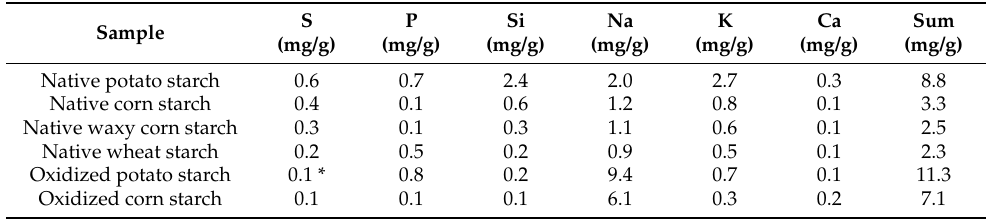
Table 3. Relative weight of contained elements analyzed by ICP-OES after liquid digestion of the starch samples by HNO 3 and H 2 O 2 with microwave